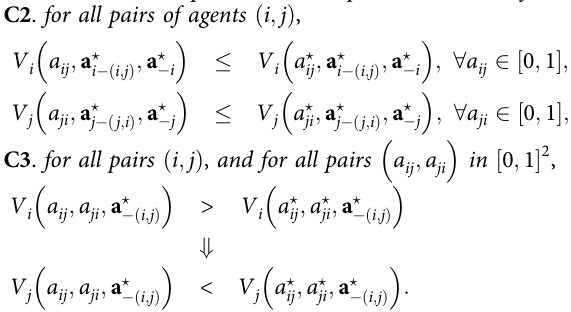
C3 . for all pairs ð i ; j Þ , and for all pairs a